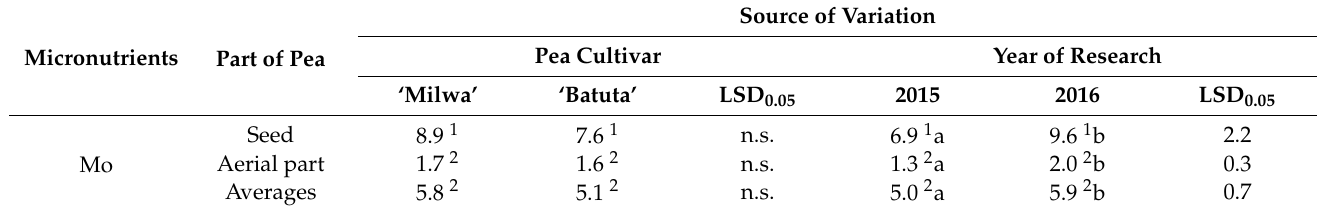
Table 10. Translocation factors of Mo, B, and Fe in aerial parts of pea (on average during the growing